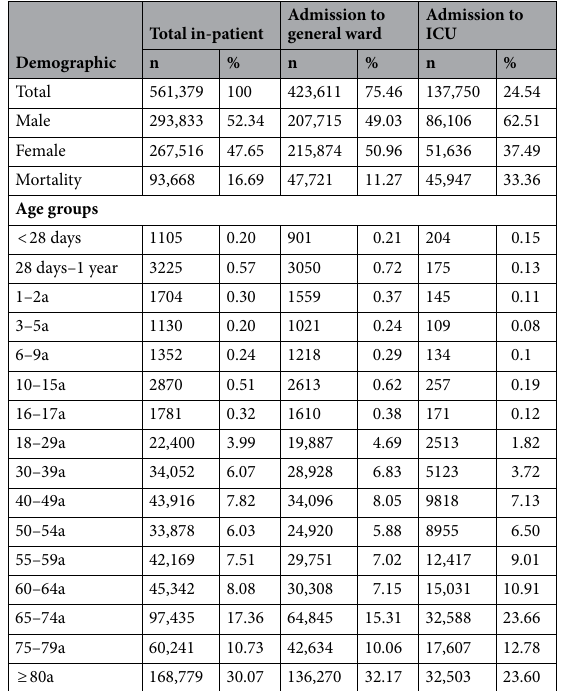
Table 2. Demographic data. Demographic data of inpatient in Germany from January 1st 2020 to December 31th 2021 with a positive SARS-CoV-2 PCR Test. Admission to general ward or admission to Intensive Care Unit